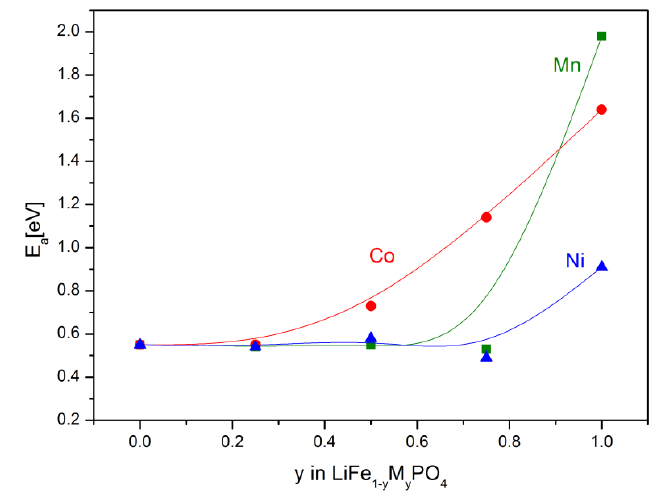
Figure 22. Temperature dependence of thermoelectric power of Li